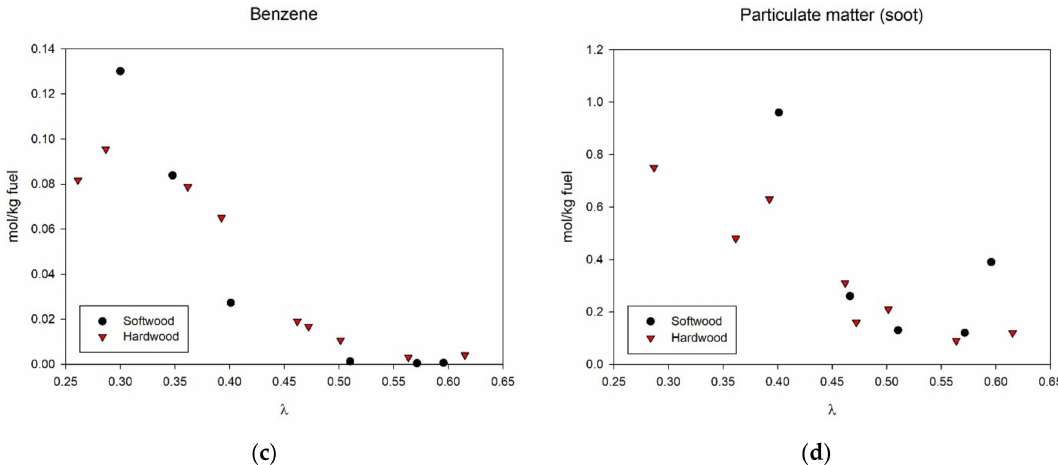
Figure 6. Gas yields of the minor syngas components ( a ) methane (CH 4 ), ( b ) acetylene (C 2 H 2 ), and ( c ) benzene (C 6 H 6 ), as well as yield of particulate matter ( d ), as a function of λ given in mol/kg